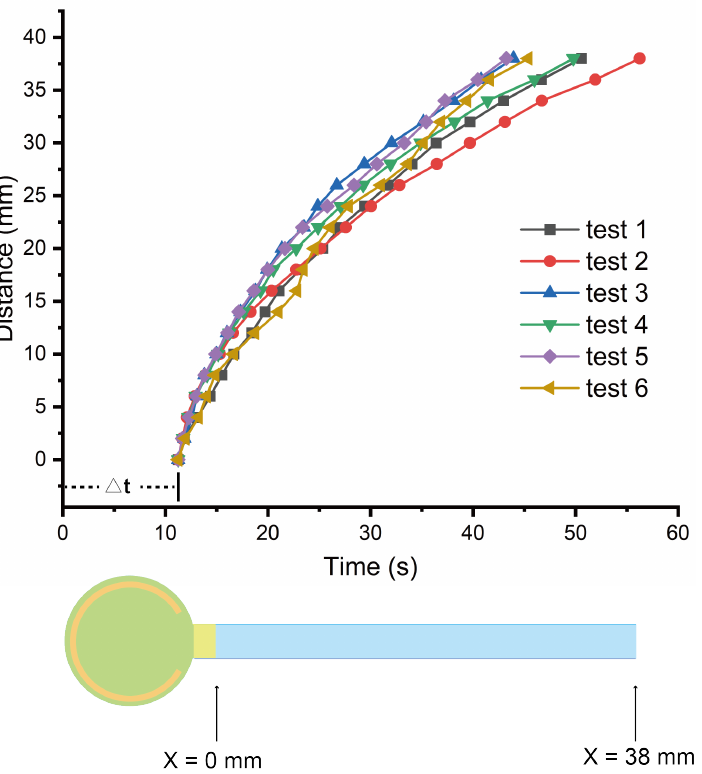
Figure 3. The flow behavior of the same blood sample on different test strips. We tested one blood sample (with hematocrit as 30.4%) on six different devices and obtained the distance–time curves of plasma flow. ∆ t indicates the time from loading the blood sample to when the plasma appears at distance X = 0 mm. The average ∆ t for this sample is 11.24